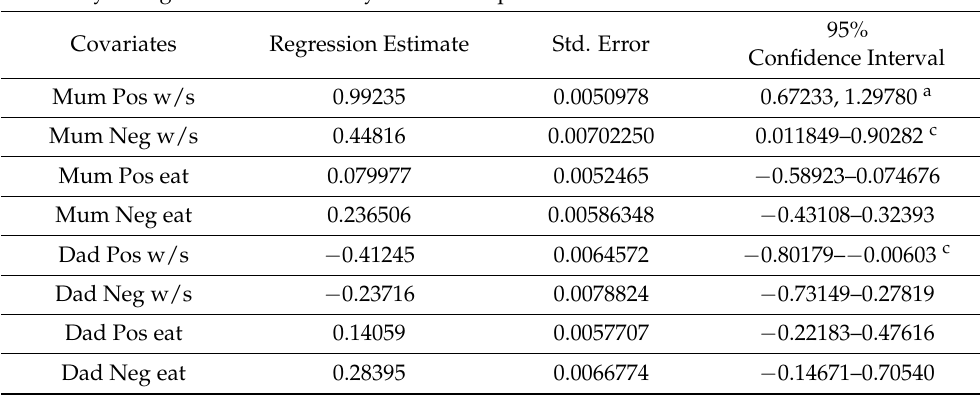
Table 1. Multiple linear regression results for the effects of maternal and paternal comment variables on psychological distress, BMI, eating disorder cognitions, and paediatric quality of life at one-year follow-ups for both